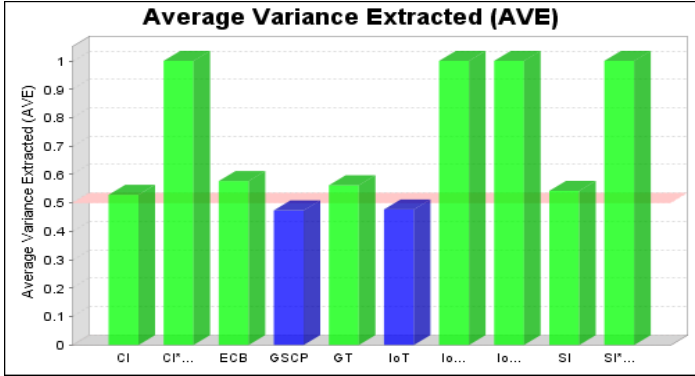
Figure 4. Average variance extracted of research variables.